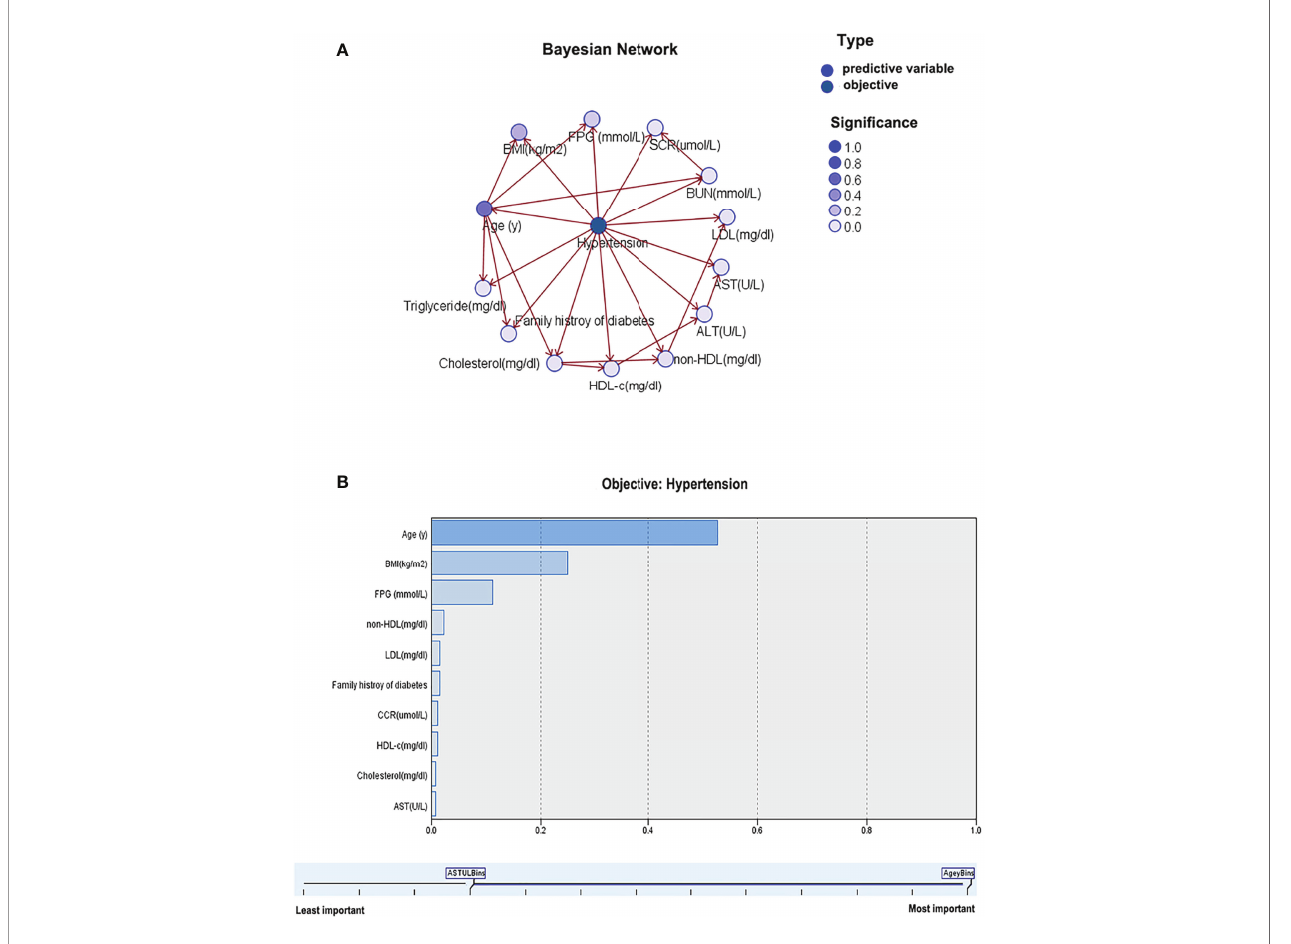
FIGURE 3 | Bayesian network model for hypertension based on TAN algorithm (A) ; Importance of predictors (B)